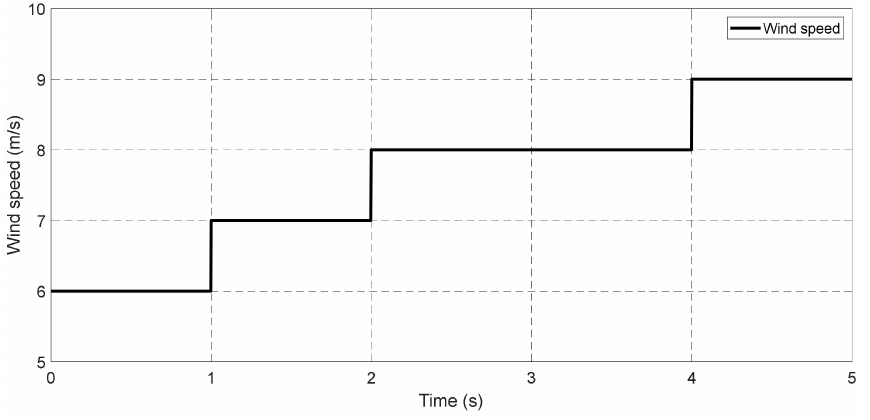
Figure 11. Wind step speed profile